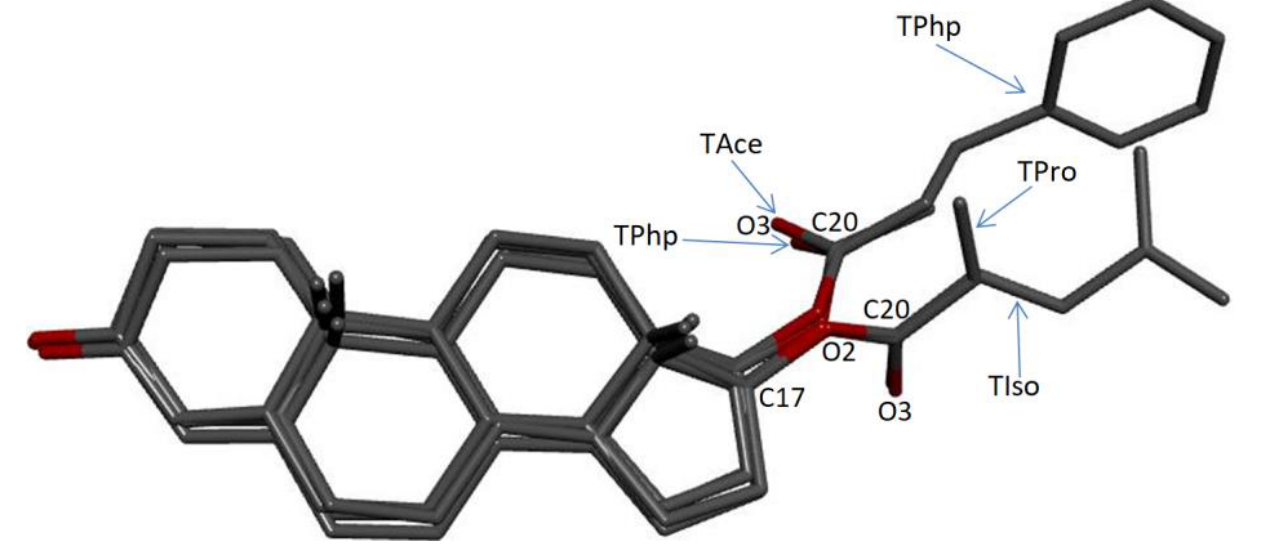
Figure 5 . Molecular overlaps of the investigated esters . Figure 5. Molecular overlaps of the investigated